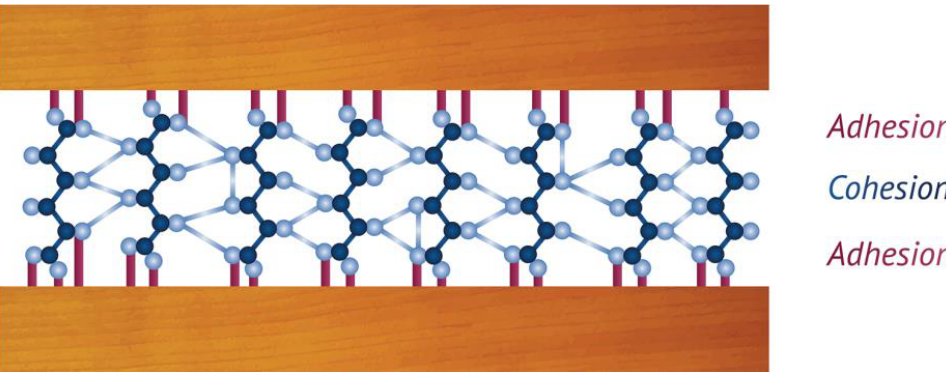
Figure 1. Adhesion and cohesion forces on wood surfaces explained by chemical bonds and inter- molecular forces [47].